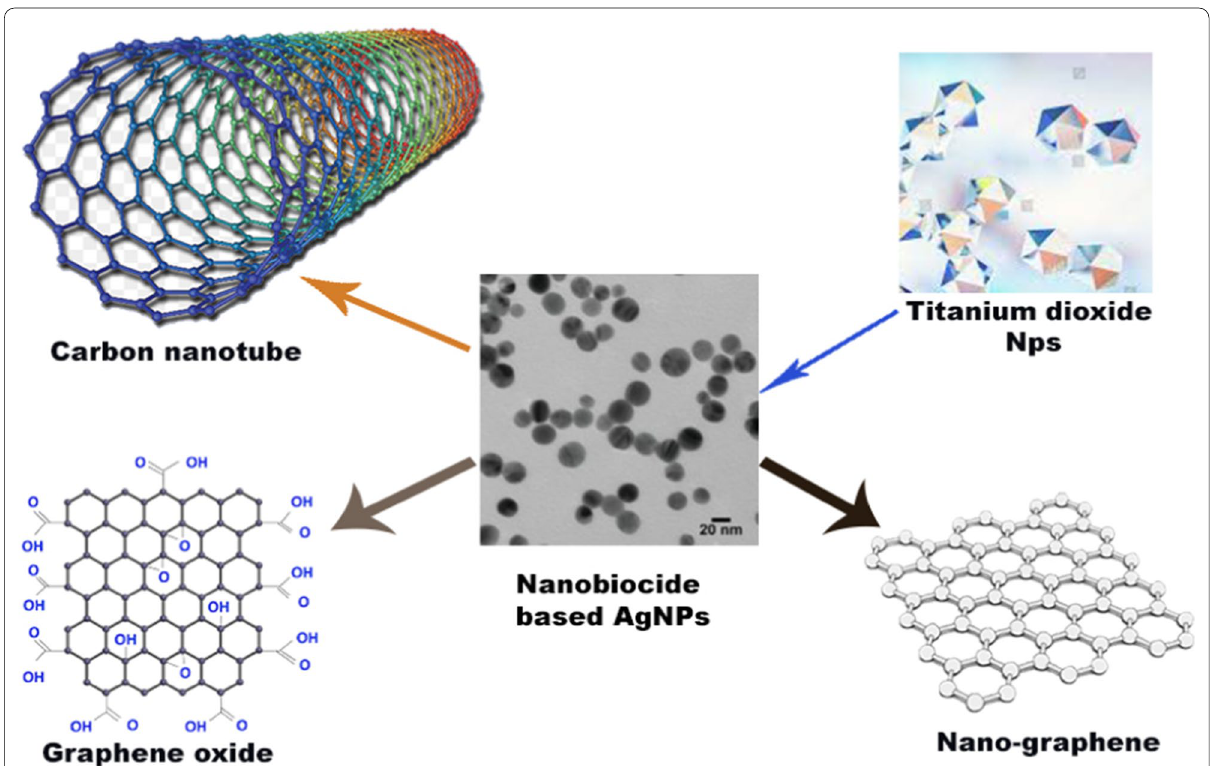
Fig. 4 Nanobiocides based AgNPs merged with carbon NMs and TiO